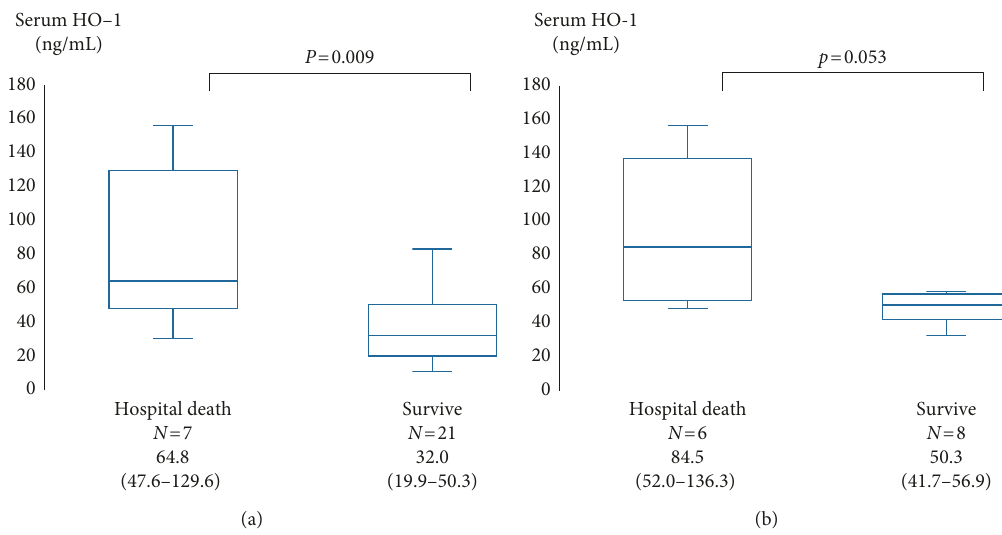
Figure 3: Comparison of the serum hemeoxygenase-1 (HO-1) level between nonsurvivors (hospital death) and survivors. The patients who subsequently died in hospital had presented with significantly higher HO-1 levels than those who survived (64.8 ng/mL vs. 32.0ng/mL; p 0 . 009) (a). Among patients having an AE, there was the similar tendency between patients who subsequently died in hospital and those (cid:31) who did not die in hospital (84.5 ng/mL vs. 50.3ng/mL; p 0 . 053) (b). The center bold line is the median value; the bottom and top of the (cid:31) boxes represent the 25 th to 75 th percentiles, respectively; and the whiskers are 95% confidence intervals. Table 3: The receiver operating characteristic curve for the serum HO-1 level (predicting hospital death among patients having an AE). Variable Area under the ROC curve Best cut-off values p value Serum hemeoxygenase-1 (ng/mL) Serum lactate dehydrogenase (U/L) Serum surfactant protein-A (ng/mL) 0.57 Serum surfactant protein-D